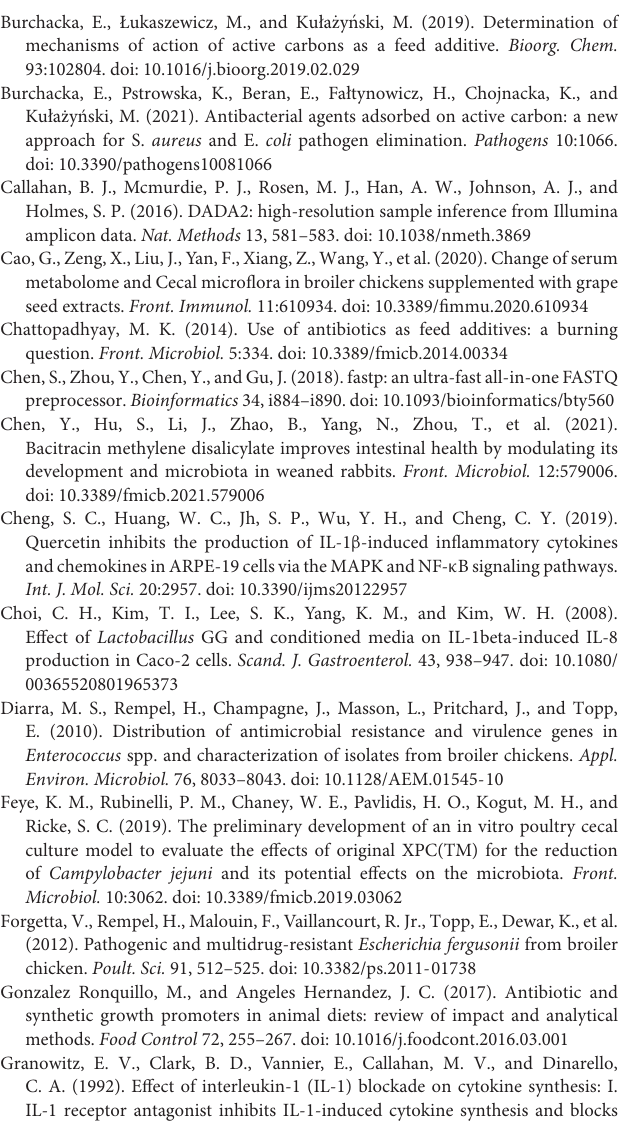
Supplementary Figure 1 | Dilution curve and rank abundance curve. (A) Rarefaction curves for total amplicon sequence variants (ASV), showing the sequencing depth with increasing sequencing depth. (B) Rank Abundance curve, showing the richness and evenness of the observed species (97% identity) based on the 16S rDNA gene.